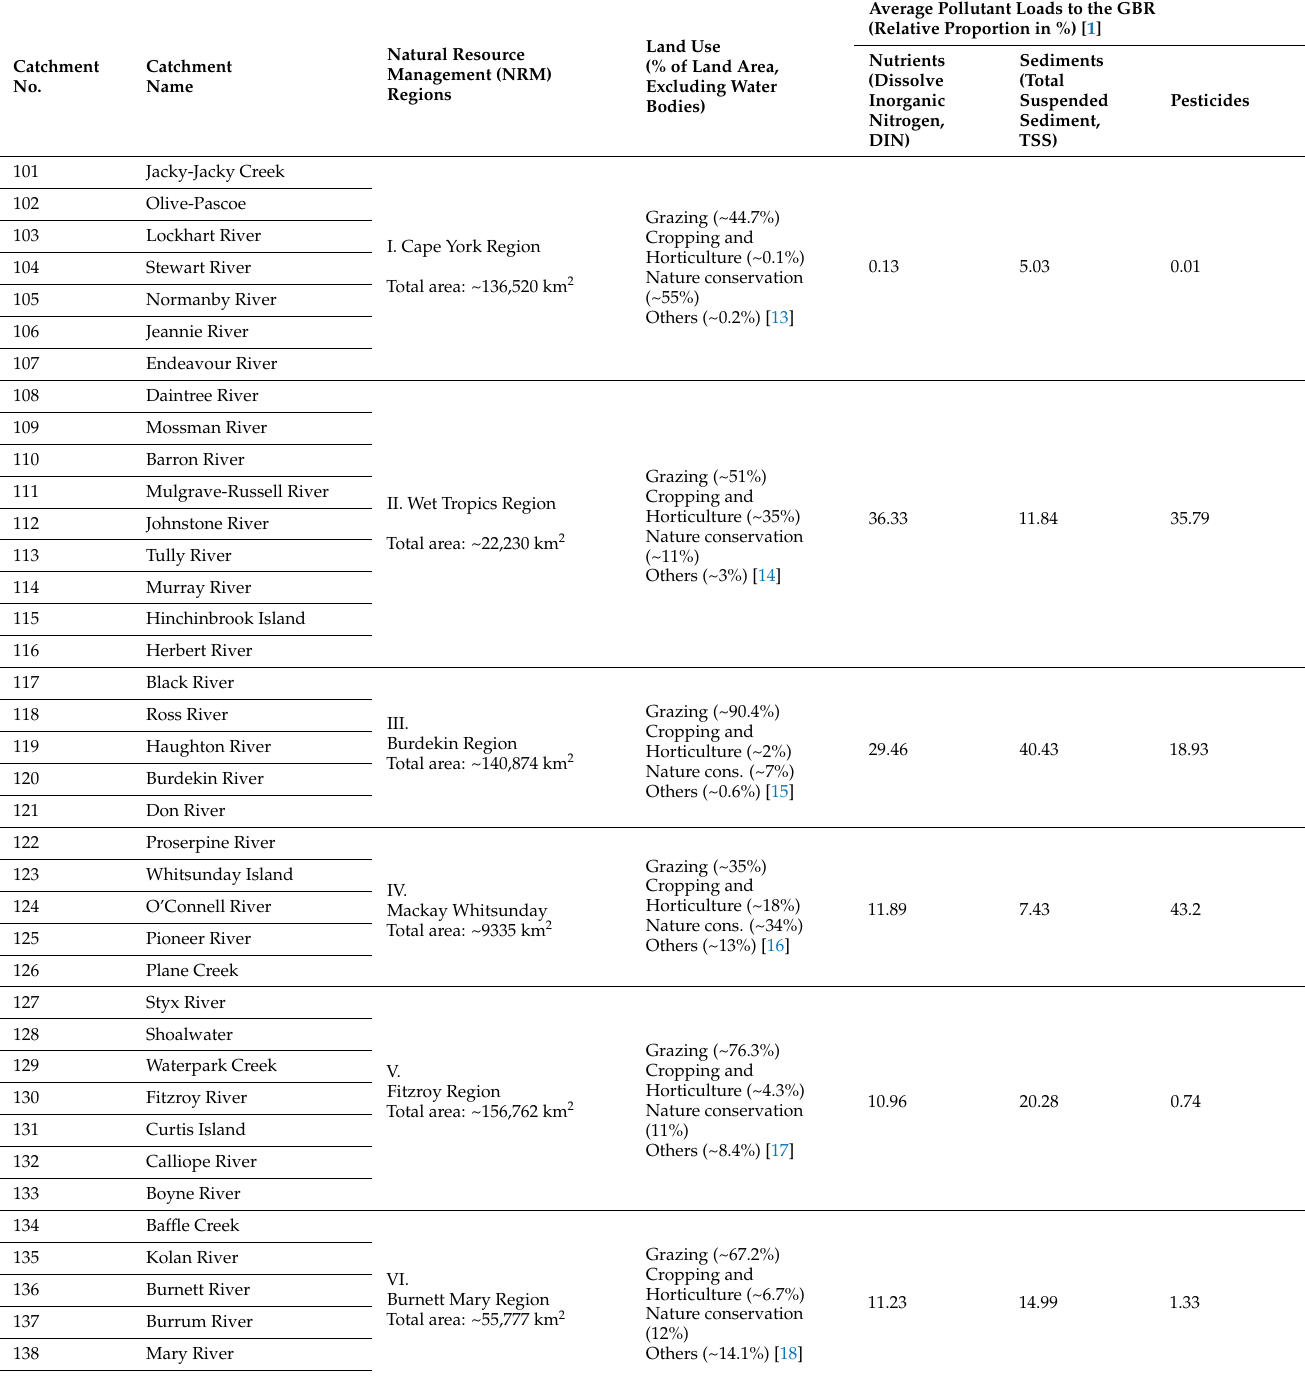
Table 1. The GBR catchments, land use and end-of-catchment pollutant load contributions [12].